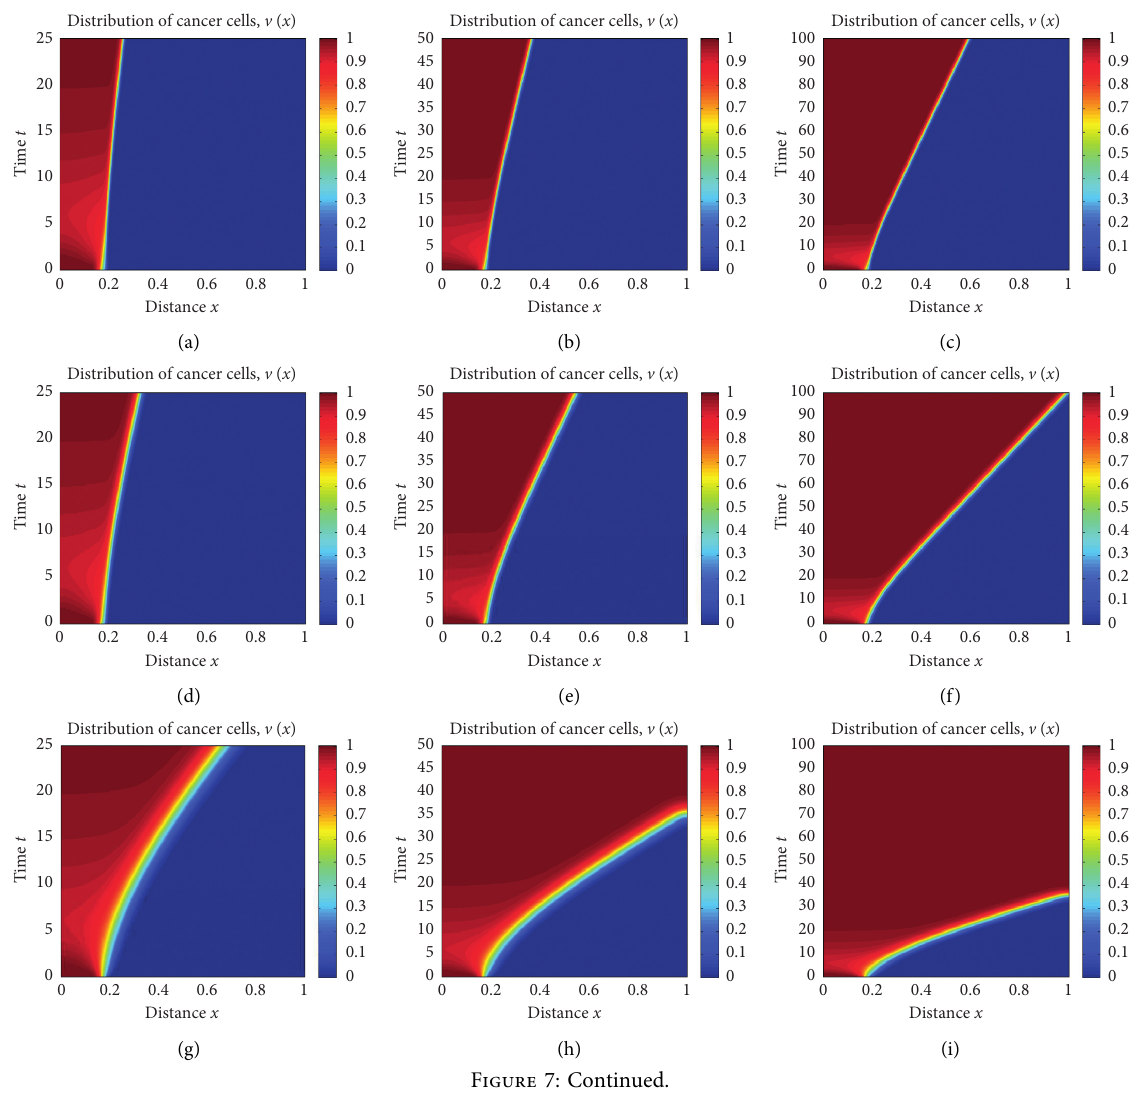
� 0 . 0000199, the third row is for d 2